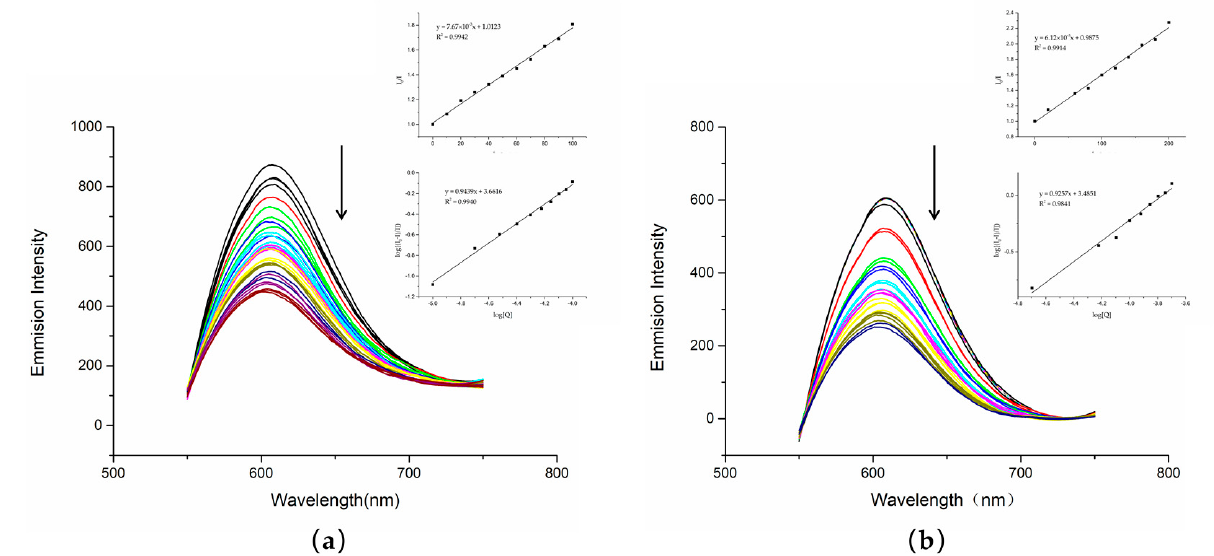
Figure 7. Fluorescence spectra of compounds dutomycin and SW91 in the absence or presence of CT-DNA in Tris-HCl buffer (pH 7.2): ( a ) emission spectra excited at 550 nm, c(dutomycin) = 0–100 μ M, c(CT-DNA) = 20 μ M, and c(EB) = 25 μ M; ( b ) emission spectra excited at 550 nm, c(dutomycin) = 0–200 μ M, c(CT-DNA) = 20 μ M, and c(EB) = 25 μ M. Table 3. Binding constant K b values of compounds dutomycin and SW91 interacting with CT-DNA- EB.